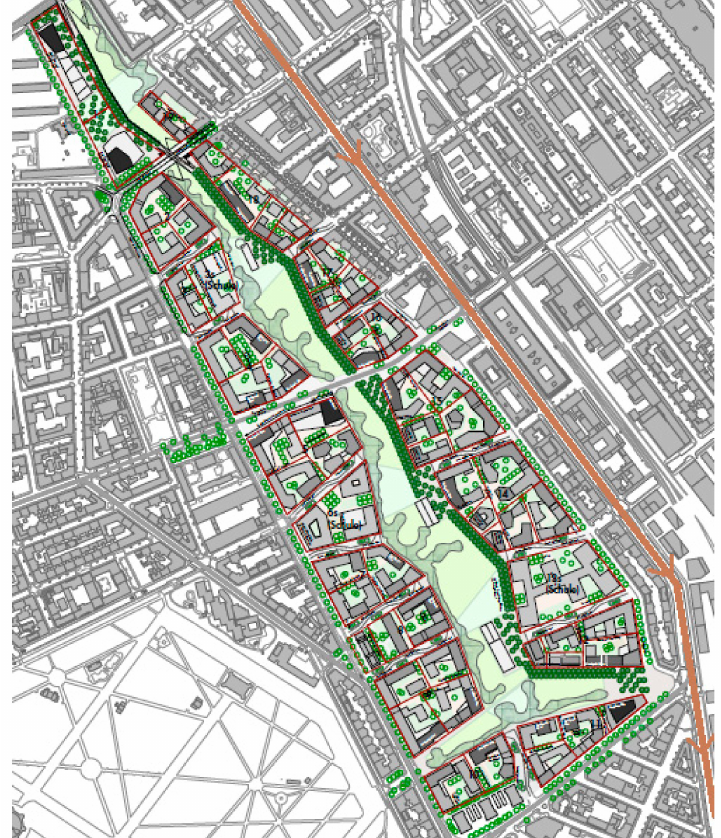
Figure 1. Overview over the intended building positions and types of use at “Nordwestbahnhof” development area, adapted with permission from [31] OEBB (internal document): Vienna, Austria, 2019, including the main sewer at the right (in brown), arrows indicate flow